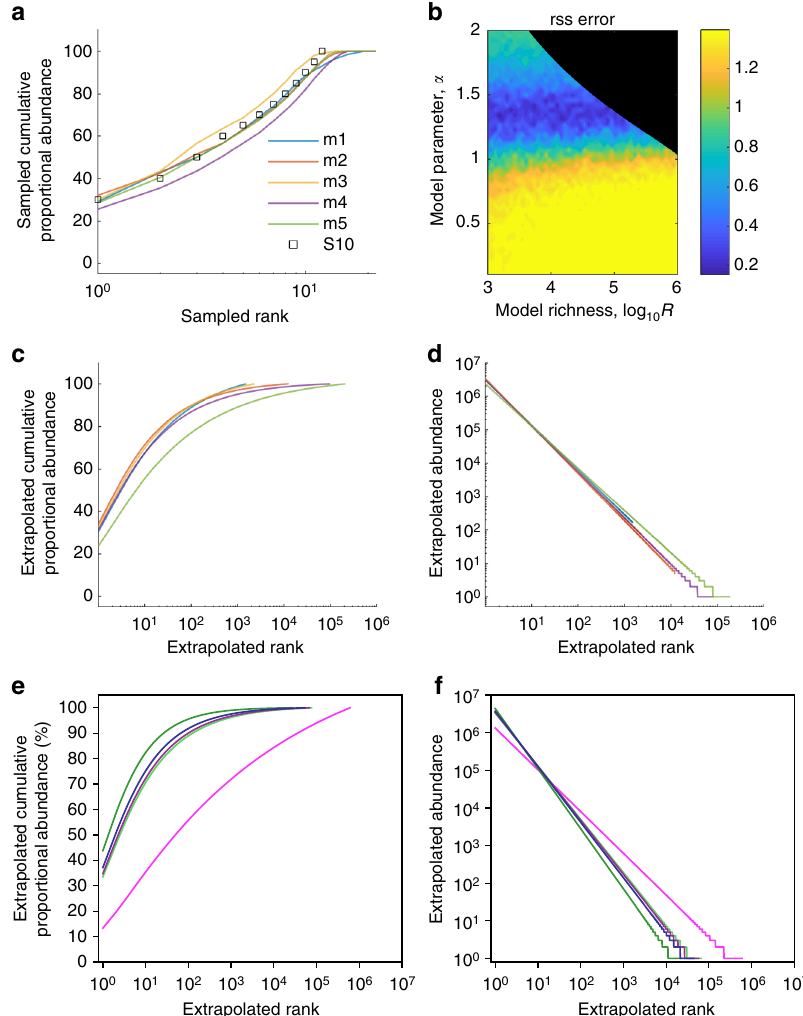
Fig. 5 Ecologic modeling suggests a majority of replication-competent HIV sequences are clonal. To describe the true rank-abundance distribution of the HIV reservoir, we used a power-law model and recapitulated experimental sampling (sample size equal to the experimental sample size) from 2500 theoretical power-law distributions to fi t the best model to participant data in Fig. 2b. Theoretical distributions varied according to the slope of the power- law and the true sequence richness but were fi xed at 10 7 replication-competent HIV DNA sequences. a Five best model fi ts (m1 – 5) to cumulative proportional abundance curves from a single representative participant (black circles: S10). b Heat map representing model fi t (dark blue optimal) according to power-law exponent α and true sequence richness R . Black shaded area represents parameter sets excluded based on mathematical constraints of the power-law (upper bound on sequence richness). A wide range of values for sequence richness allow excellent model fi t while power-law exponent is well-de fi ned. c , d Extrapolations of fi ve best models for a single participant to a reservoir size of 10 7 cells carrying replication-competent HIV. c Cumulative proportional abundances show that the top 200,000 ranked clones constitute the entire reservoir. d Rank-abundance curves show the top 100 clones consist of >2000 cells each. e , f Extrapolations of the maximum richness best- fi t model for each suf fi ciently sampled participant (colored to match Fig. 2b) to a replication-competent reservoir size of 10 7 cells. e For each participant, even with the maximum possible sequence richness, we note a predominance of sequence clones. 50% of the reservoir may be held in the top 2 to 20 clones. f A small number of massive clones (top 100 clones) each consist of >10 3 cells and a massive number of smaller clones (~10 5 ) each consist of many fewer cells